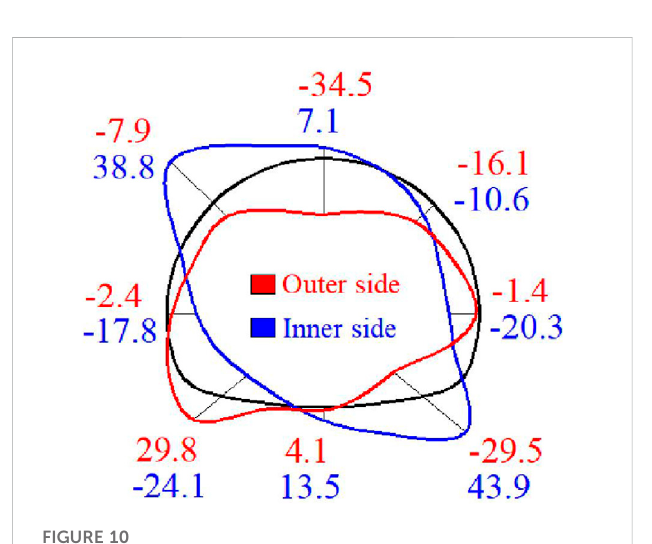
FIGURE 10 Circumferential stress of supporting structure (unit: kPa).